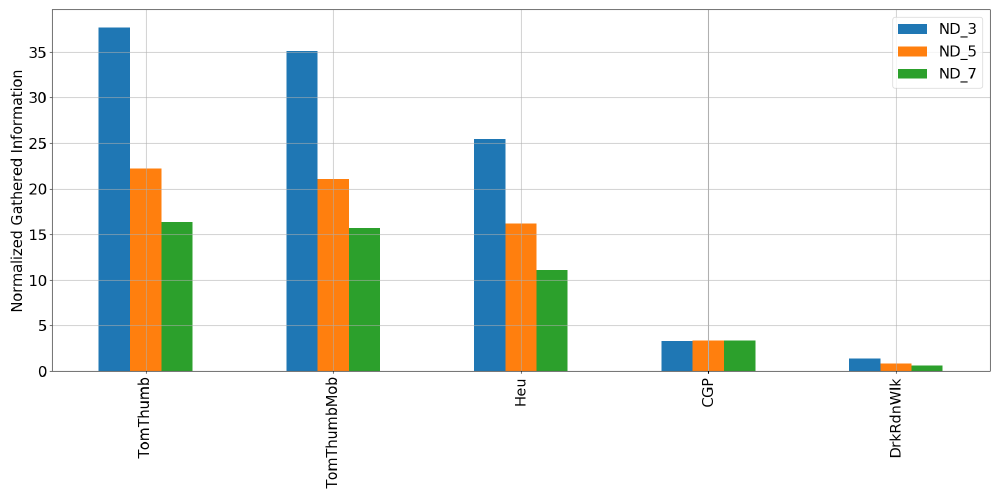
Figure 9. Normalised gathered information comparisons among the proposed TT and alternative approaches for Scenario 2 and different ND values in the presence also of a low mobility pattern.